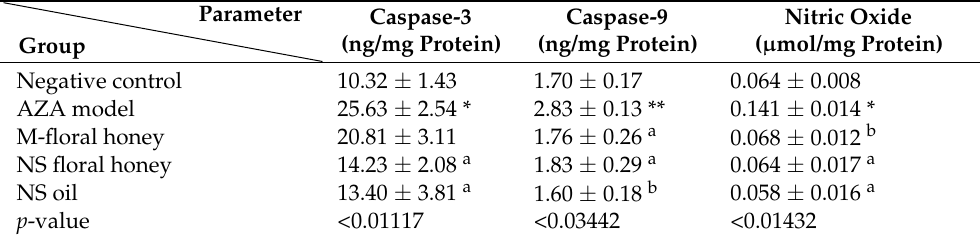
Table 4. Effects of M-floral honey, NS floral honey, and NS oil on caspase-3, caspase-9, and nitric